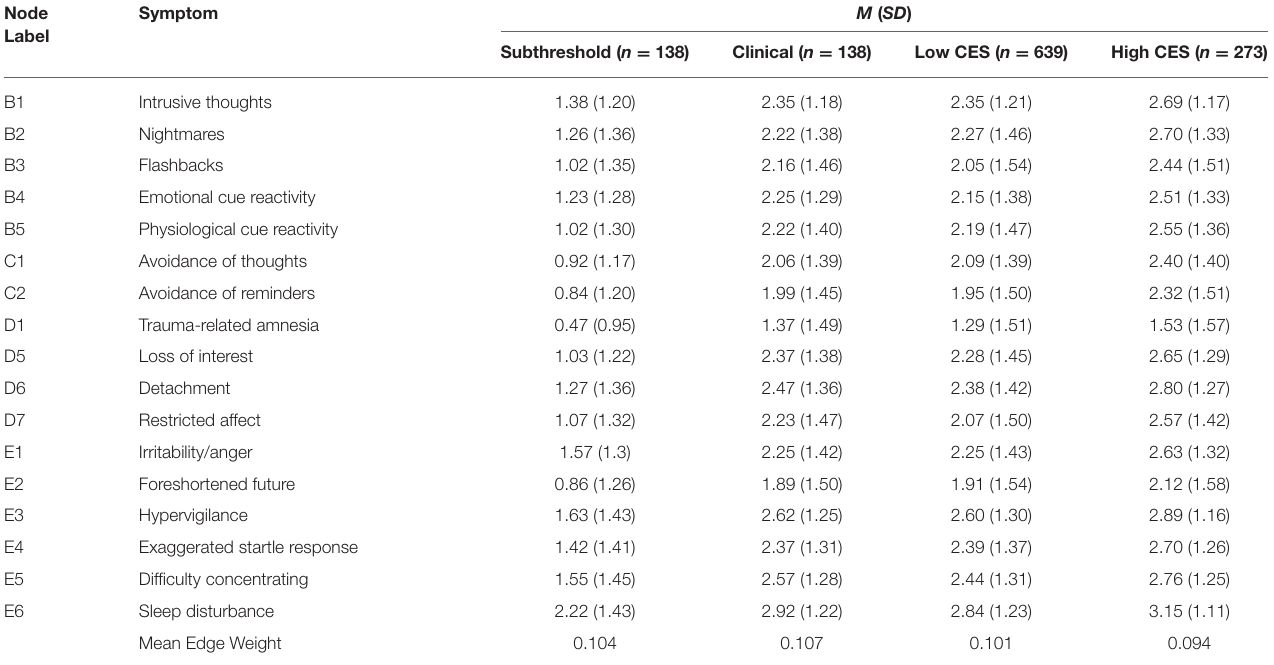
TABLE 2 | Means and standard deviations for PTSD symptoms within veteran subgroups and mean edge weight for each symptom